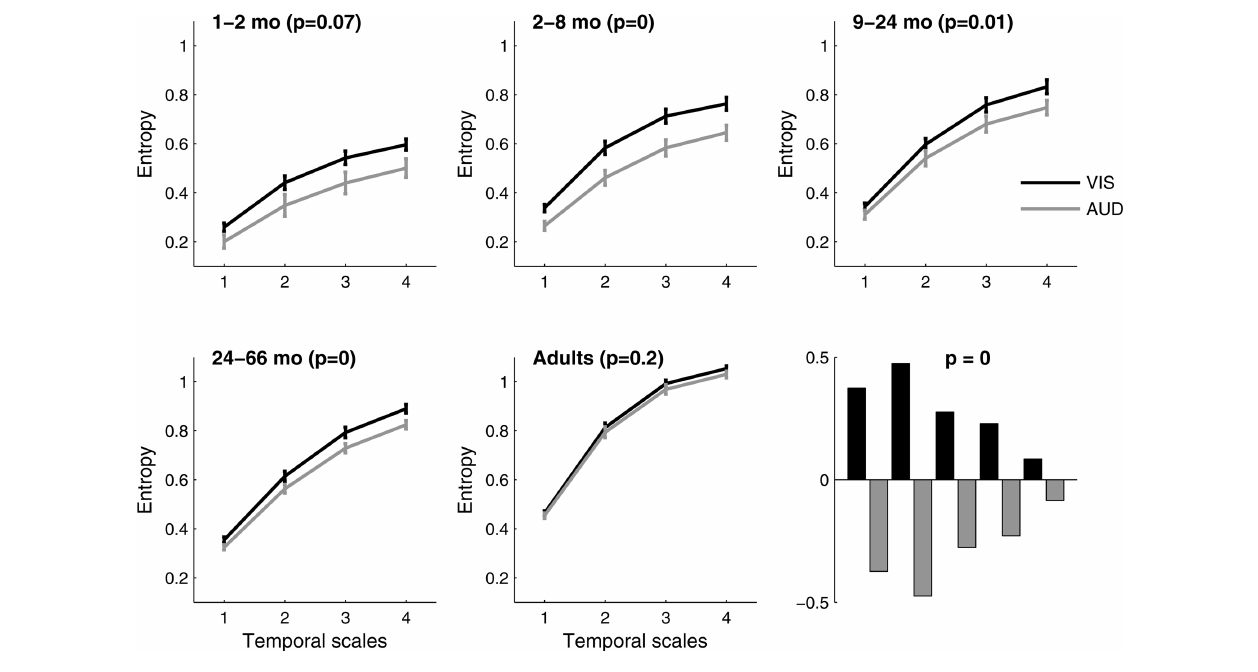
FIGURE 4 | Multi scale entropy in VIS vs. AUD conditions across fi ve age groups. Group mean entropy is shown for VIS and AUD conditions, together with group standard errors. The outcome of the signifi cance testing for differences in MSE between two conditions within each group are given as p values. The adult group showed no signifi cant differences between the two conditions. Bottom right panel shows PLS contrast between VIS